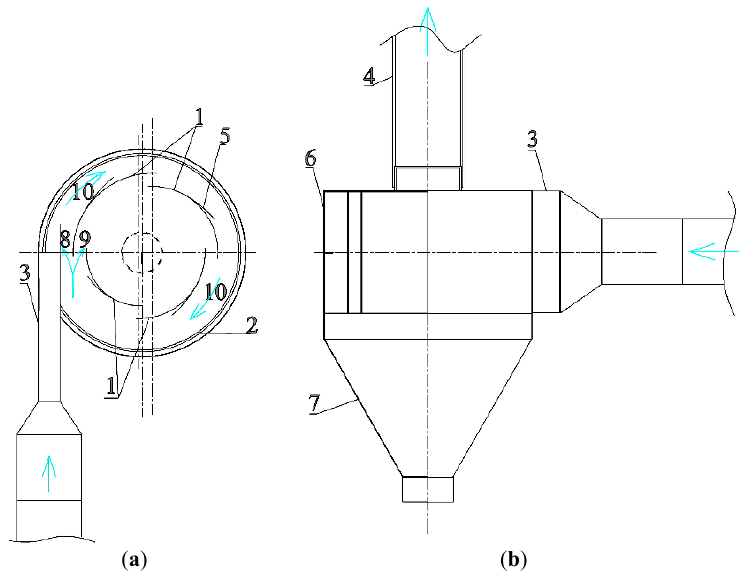
Figure 1. Multi ‐ channel single ‐ inlet cyclone ( a ) top view and ( b ) side view: 1—internal curved quarter ‐ ring elements with openings cut, 2—ringed continuous slit, 3—a single inflow, 4—cleaned air outflow, 5—plates of quarter ‐ rings, 6—cyclone separation chamber, 7—conical hopper, 8, 9—peripheral and transitional distribution flows, 10—circulating airflow in the cyclone’s channels.